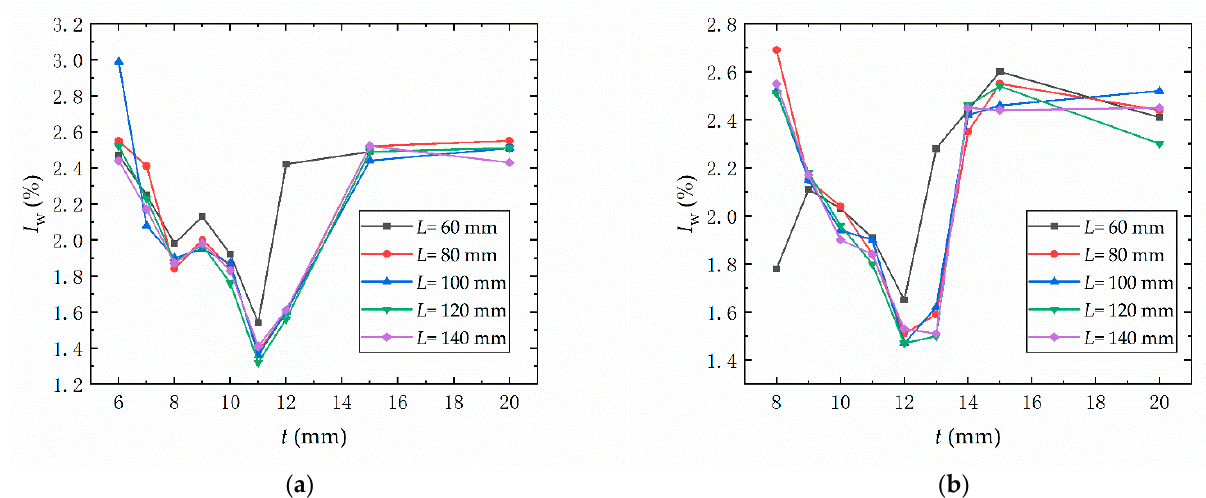
Figure 10. Influence of hollow section parameters on I w : ( a ) hollow mandrel scheme 1; ( b ) hollow mandrel scheme 2.